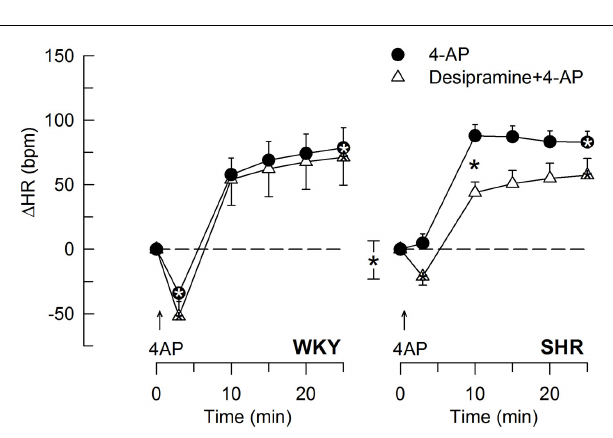
FIGURE 6 |The effect of the norepinephrine reuptake inhibitor desipramine on the HR-response to 4-AP. Significant responses (* within symbol) at HR nadir and at 25min were located as indicated. A difference between the SHR control and the desipramine-treated group was detected at 10min (* between curves). Baseline HR was not different after desipramine ( Table 2 ). * – P ≤ 0.025 and 0.0167 for significant responses and group differences, respectively.